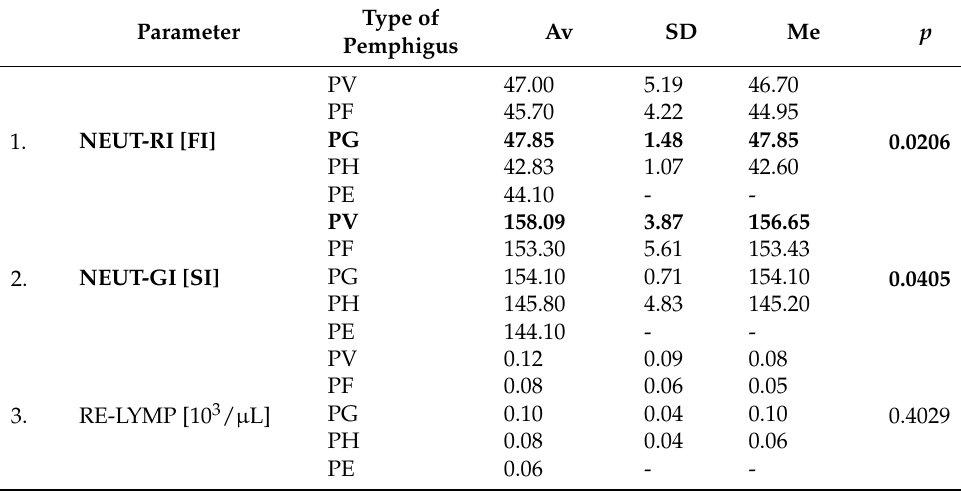
Table 3. Dependence of selected parameters on the type of